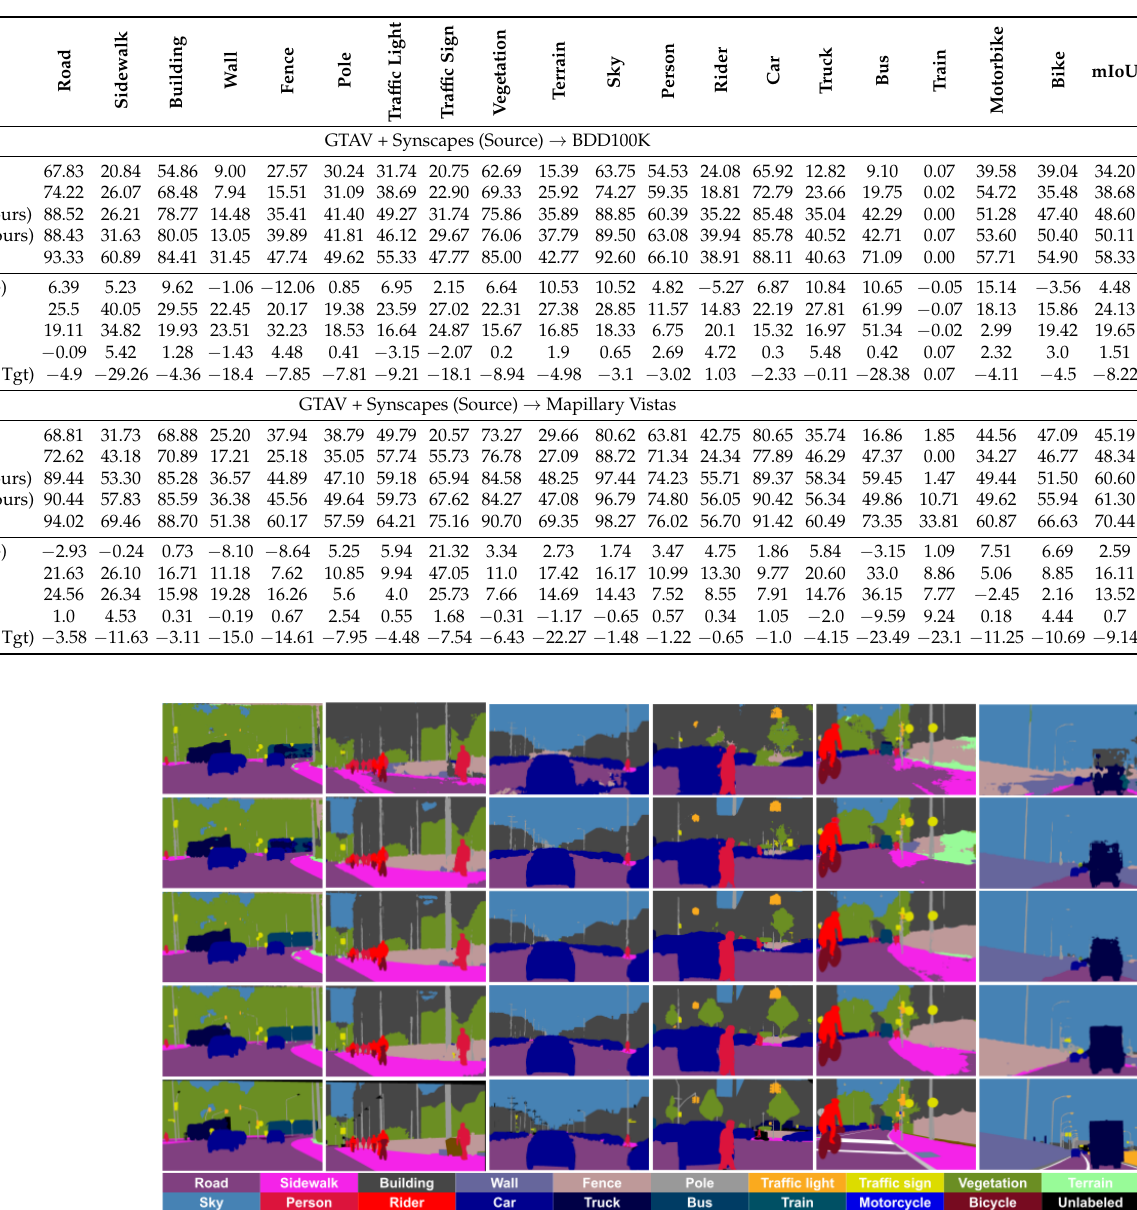
Table 5. Analogous to Table 3 with BDD100K and Mapillary as target domains.